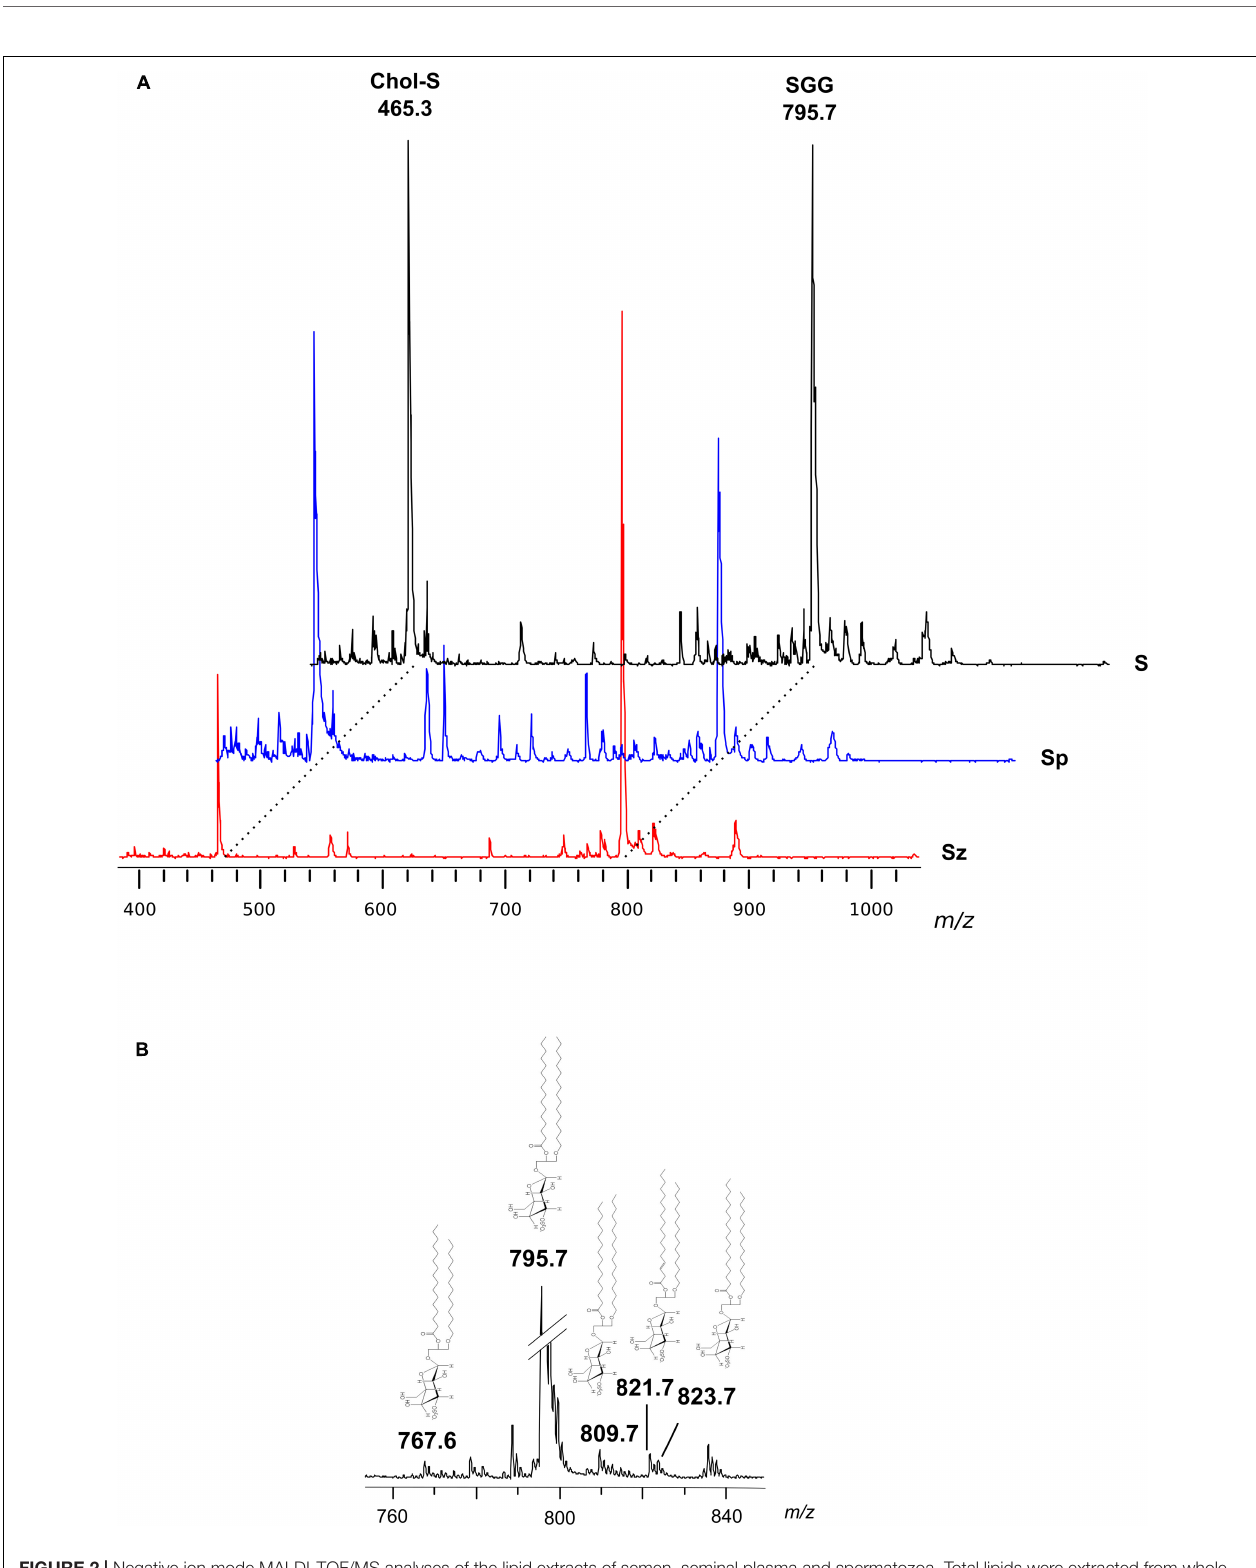
FIGURE 2 | Negative ion mode MALDI-TOF/MS analyses of the lipid extracts of semen, seminal plasma and spermatozoa. Total lipids were extracted from whole semen ( S ) as well as from related spermatozoa ( Sz ) and seminal plasma ( Sp ) obtained from a man with normozoospermia. In panel (A) , the typical lipid profiles are shown. The main peaks are attributable to Chol-S [M–H] − at m/z 465.3 and SGG O-32:0 [M–H] − at m/z 795.7. In panel (B) , the enlargement of the region at m/z 760–840 of mass spectrum of S is shown. The peaks at m/z 767.6, 809.7, 821.7, and 823.7 are assigned to other SGG species (O-30:0, O-33:0, O-34:1 or P-34:0, and O-34:0, respectively); their molecular structures are also